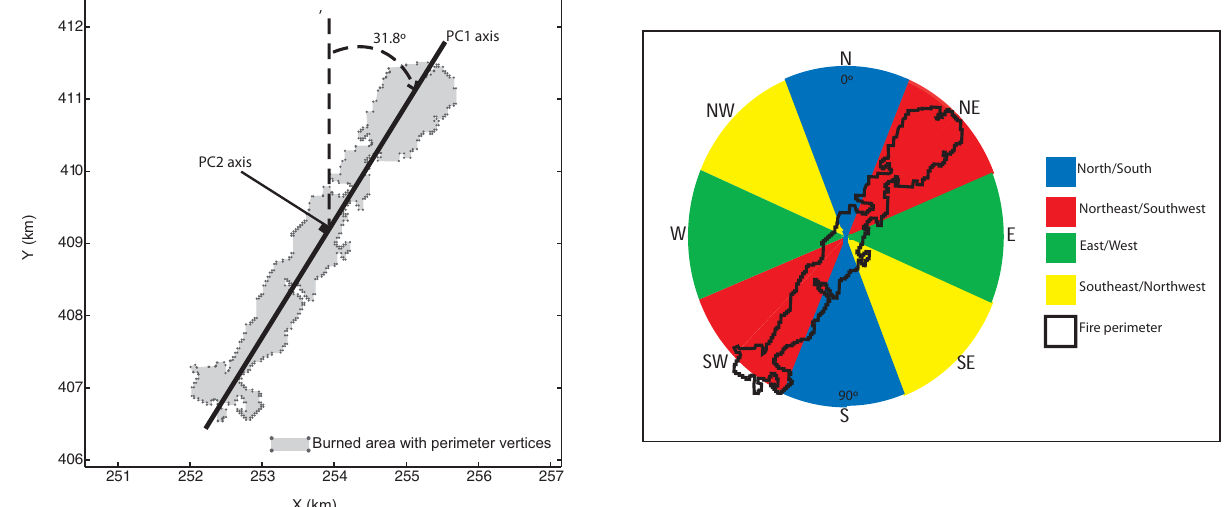
Figure 3. On the the left, fire perimeter vertices are represented by its X and Y coordinates, in a bi-dimensional space. The first principal component axis (PC1 axis) corresponds to the axis that maximizes the variance among the projection of all points that constitute the object boundary and also reflects the object’s orientation. On the right, classification of axial data is in the compass orientation. Fires and watersheds have orientations, rather then directions; therefore, their orientation values range from 0–180 ◦ . Compass classification is a function of the orientation value, θ or , as follows: N/S ⇔ θ or ∈ [0; 22 . 5] ∧ θ or ∈ ]157 . 5; 180] ;